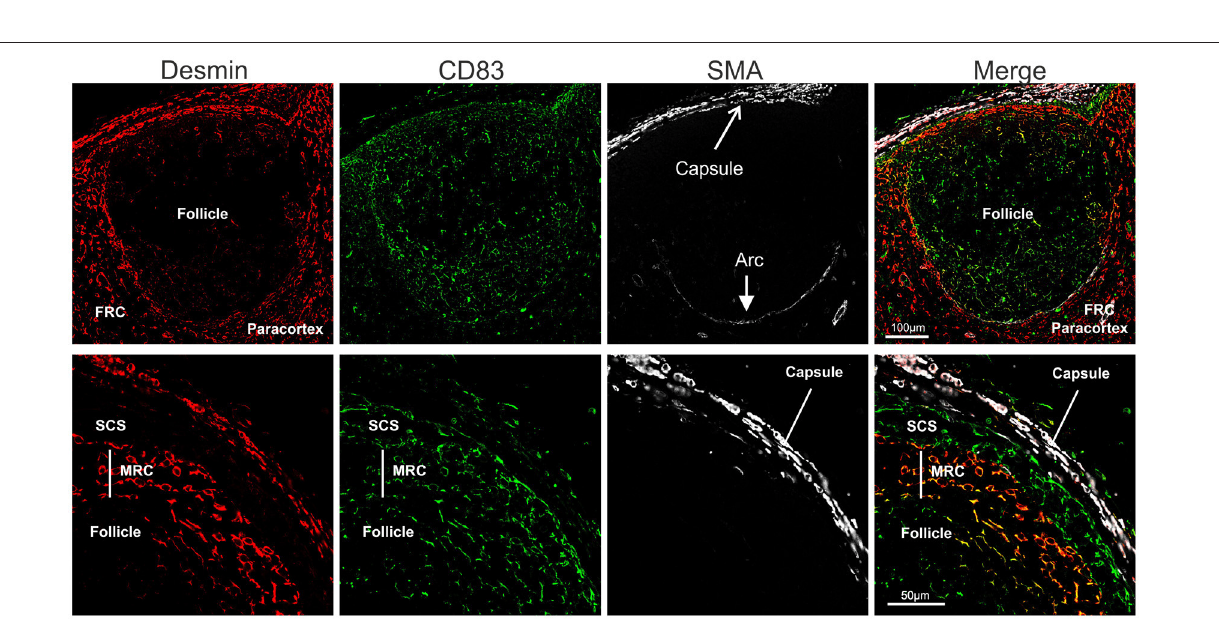
Frontiers in Immunology | www.frontiersin.org